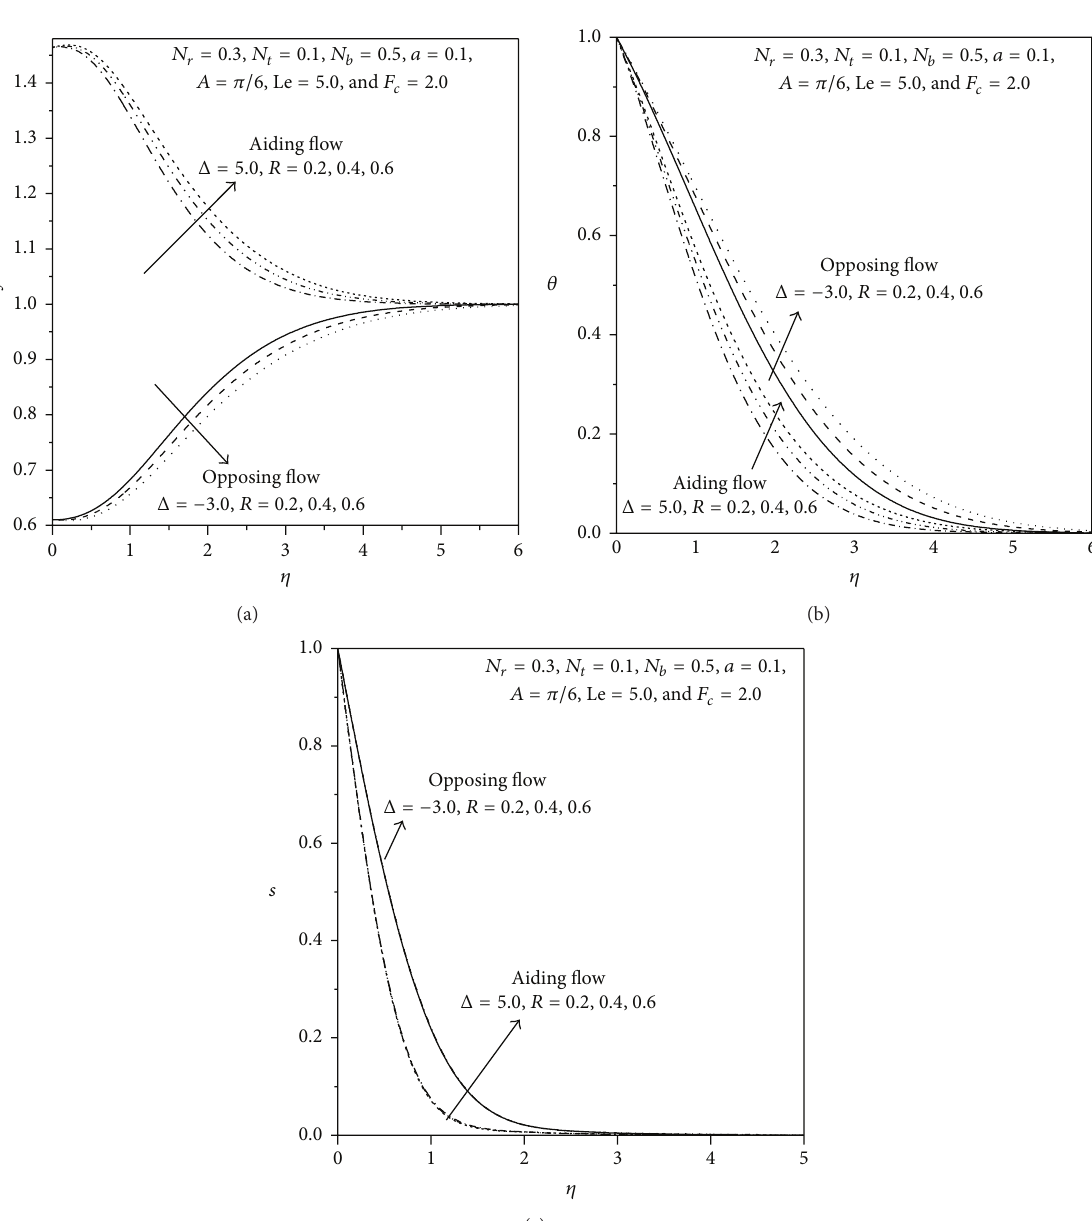
flows. In general, we conclude that increasing the wave amplitude makes the surface more